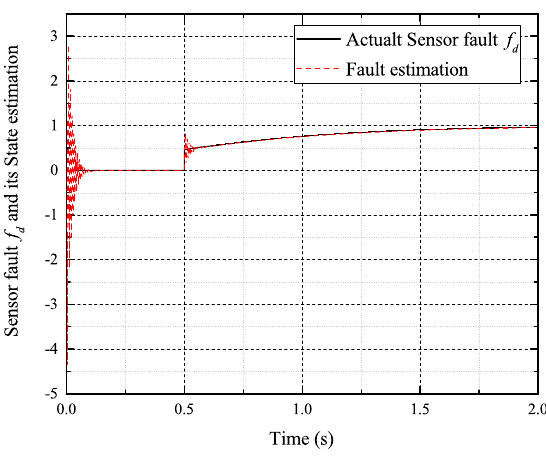
Figure 6. Sensor fault f d and its estimated value ˆ f d .